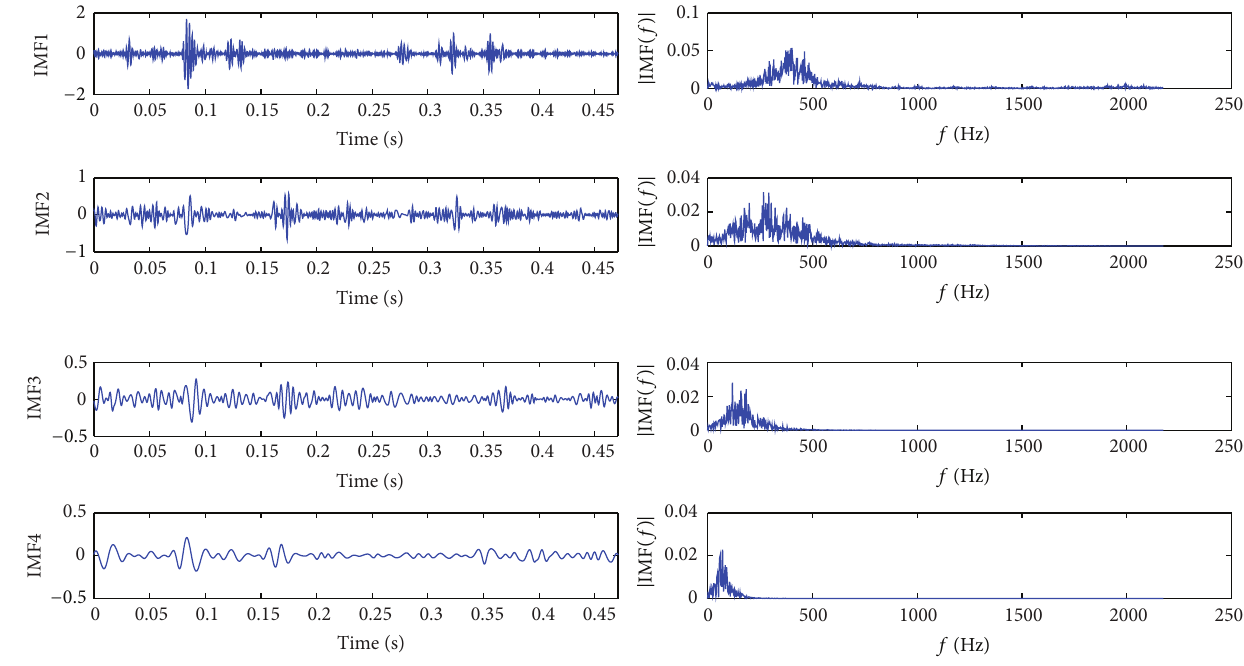
Figure 6: Main components of IMF achieved by means of EMD.